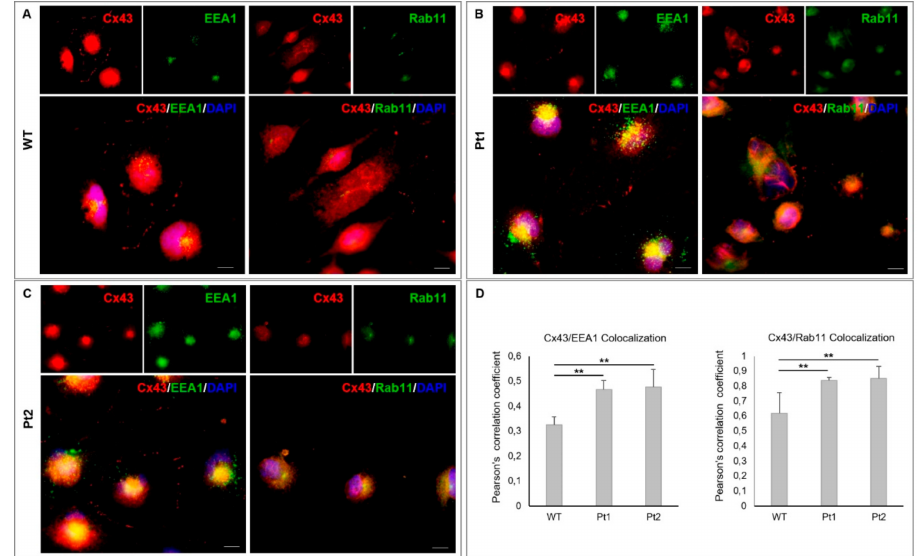
Figure 4. Analysis of Cx43 intracellular tra ffi cking in U251 astrocytoma cells overexpressing MLC1 WT or carrying Pt1 and Pt2 pathological mutations: ( A – C ) Double immunofluorescence staining